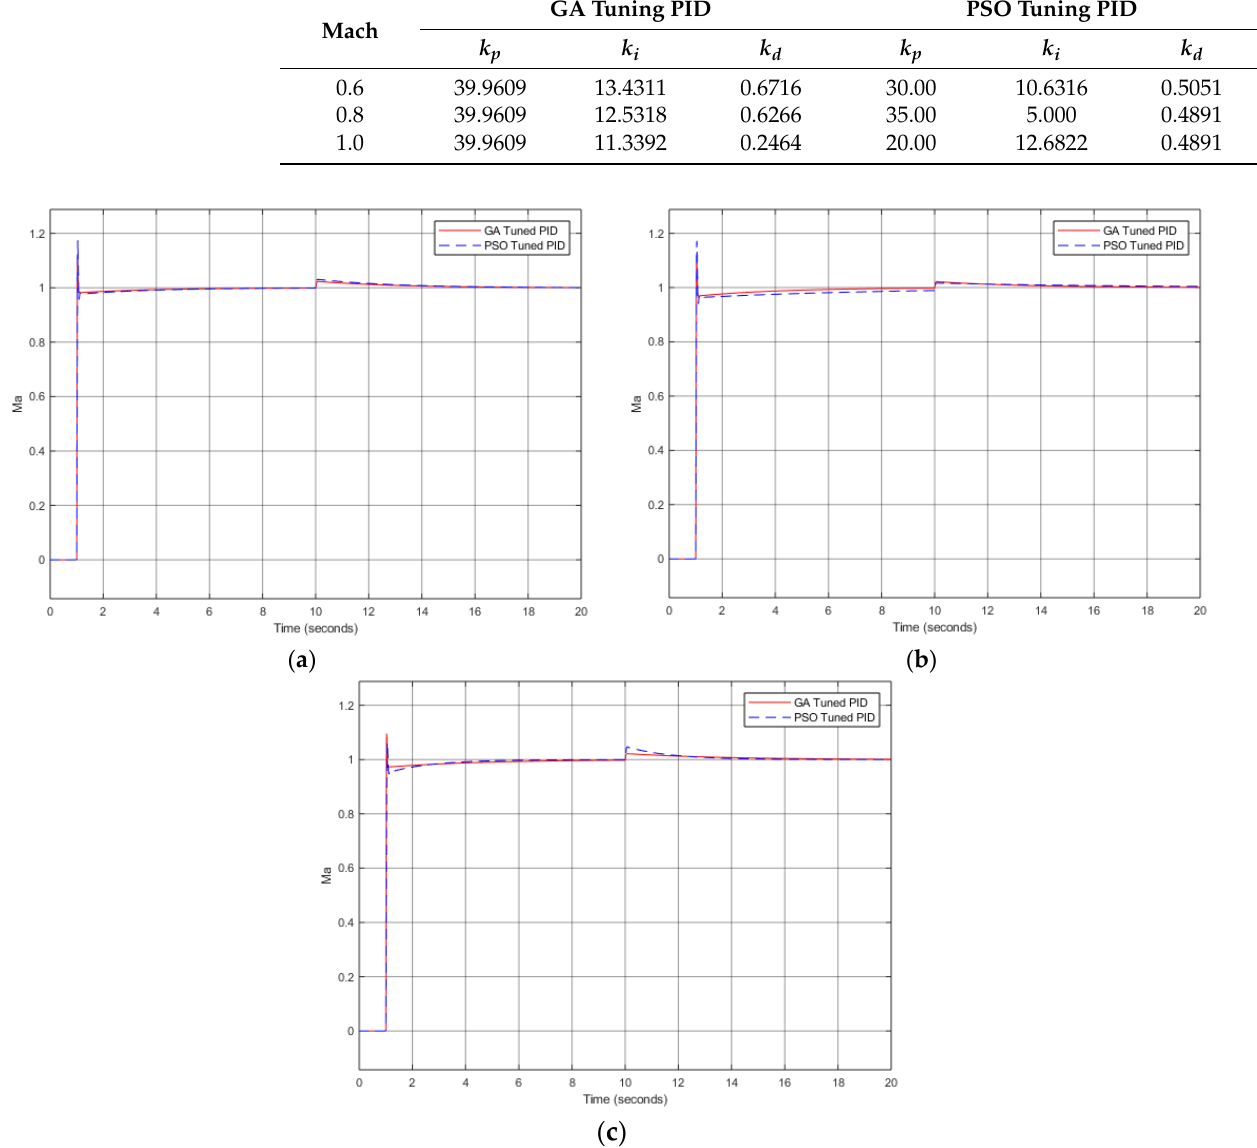
Figure 4. Mach number control results. ( a ) Mach 0.6. ( b ) Mach 0.8. ( c ) Mach